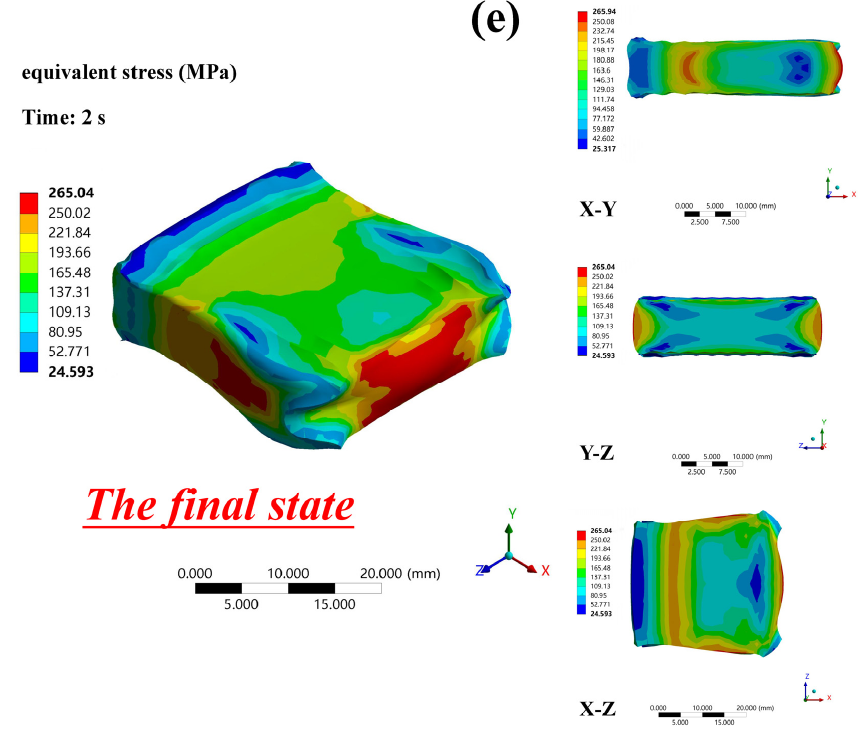
Figure 7. The equivalent stress distribution of conventional rolled alloy. ( a ) Deformation state of 0.22513 s; ( b ) Deformation state of 0.6979 s; ( c ) Deformation state of 1.0024 s; ( d ) Deformation state of 1.5 s; ( e ) Deformation state of 2.0 s.